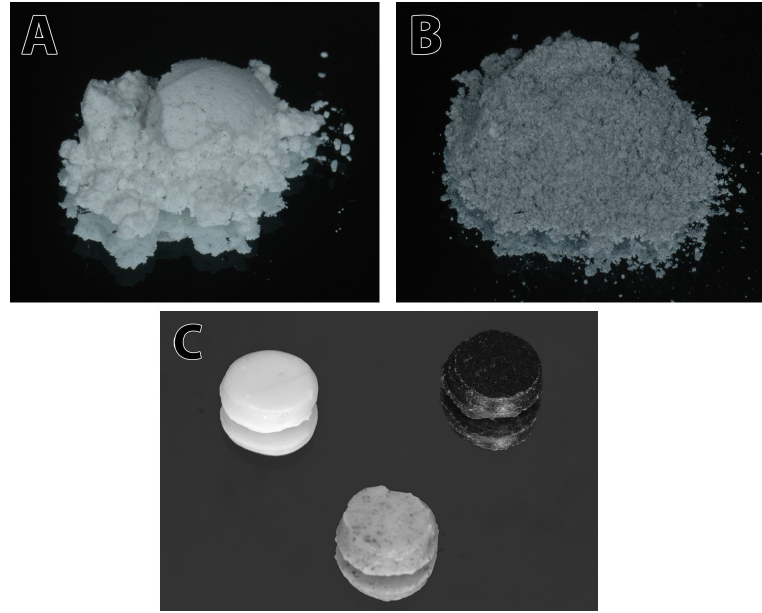
Figure 1. Glass ionomer powder with RGO in the proportion of 0.1% (A) and 3% (B); samples of pure GIC and test GIC with RGO in the proportion of 0.1% and 3% after cure (C).